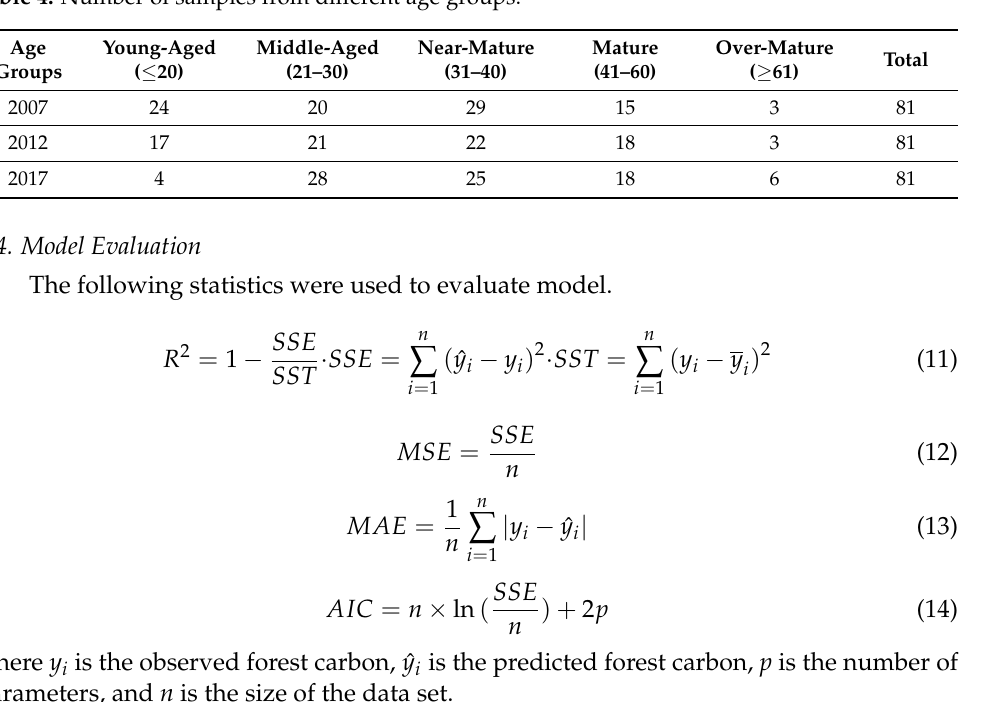
Table 4. Number of samples from different age